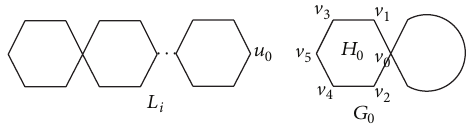
Figure 1: Two chain hexagonal cacti 𝐿 𝑖 and 𝐺 0